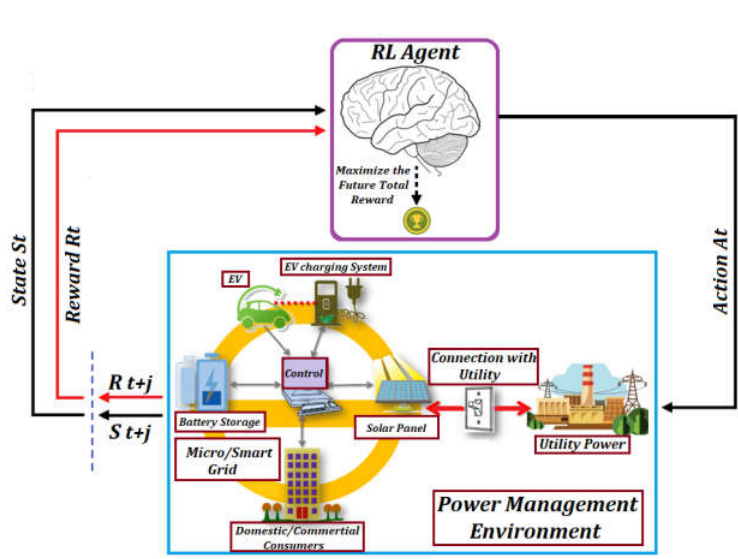
Figure 2. Markov process and the verification of the total future reward.